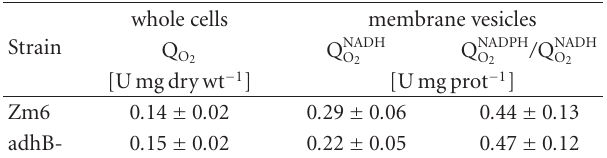
Figure 3: Intracellular NAD(P)H concentration in aerobic and anaerobic steady-state chemostat cultures; empty bars—Zm6, filled bars—adhB-. The total of both reduced cofactor concentrations is given. Continuous cultivation parameters were as described in Section 2. Table 1: Oxygen uptake rates of cells and cytoplasmic membrane vesicles. Cells grown overnight without aeration were used for the whole-cell experiments and membrane preparation. Oxygen uptake measurements in membrane preparations were carried out in 50mM phosphate bu ff er, containing membranes at concentration of 0.4-0.5 mg protein mL − 1 , and 1.5mM NADH or NADPH. For the whole-cell oxygen uptake measurements, 10 gL − 1 glucose was added to anaerobic cell suspensions (7mgdrywtmL − 1 in 50 mM potassium phosphate bu ff er, pH 6.9). After 5 minutes of incubation the suspensions were diluted tenfold with air-saturated phosphate bu ff er, containing 2g L − 1 glucose and 2gL − 1 ethanol, and oxygen consumption rate was